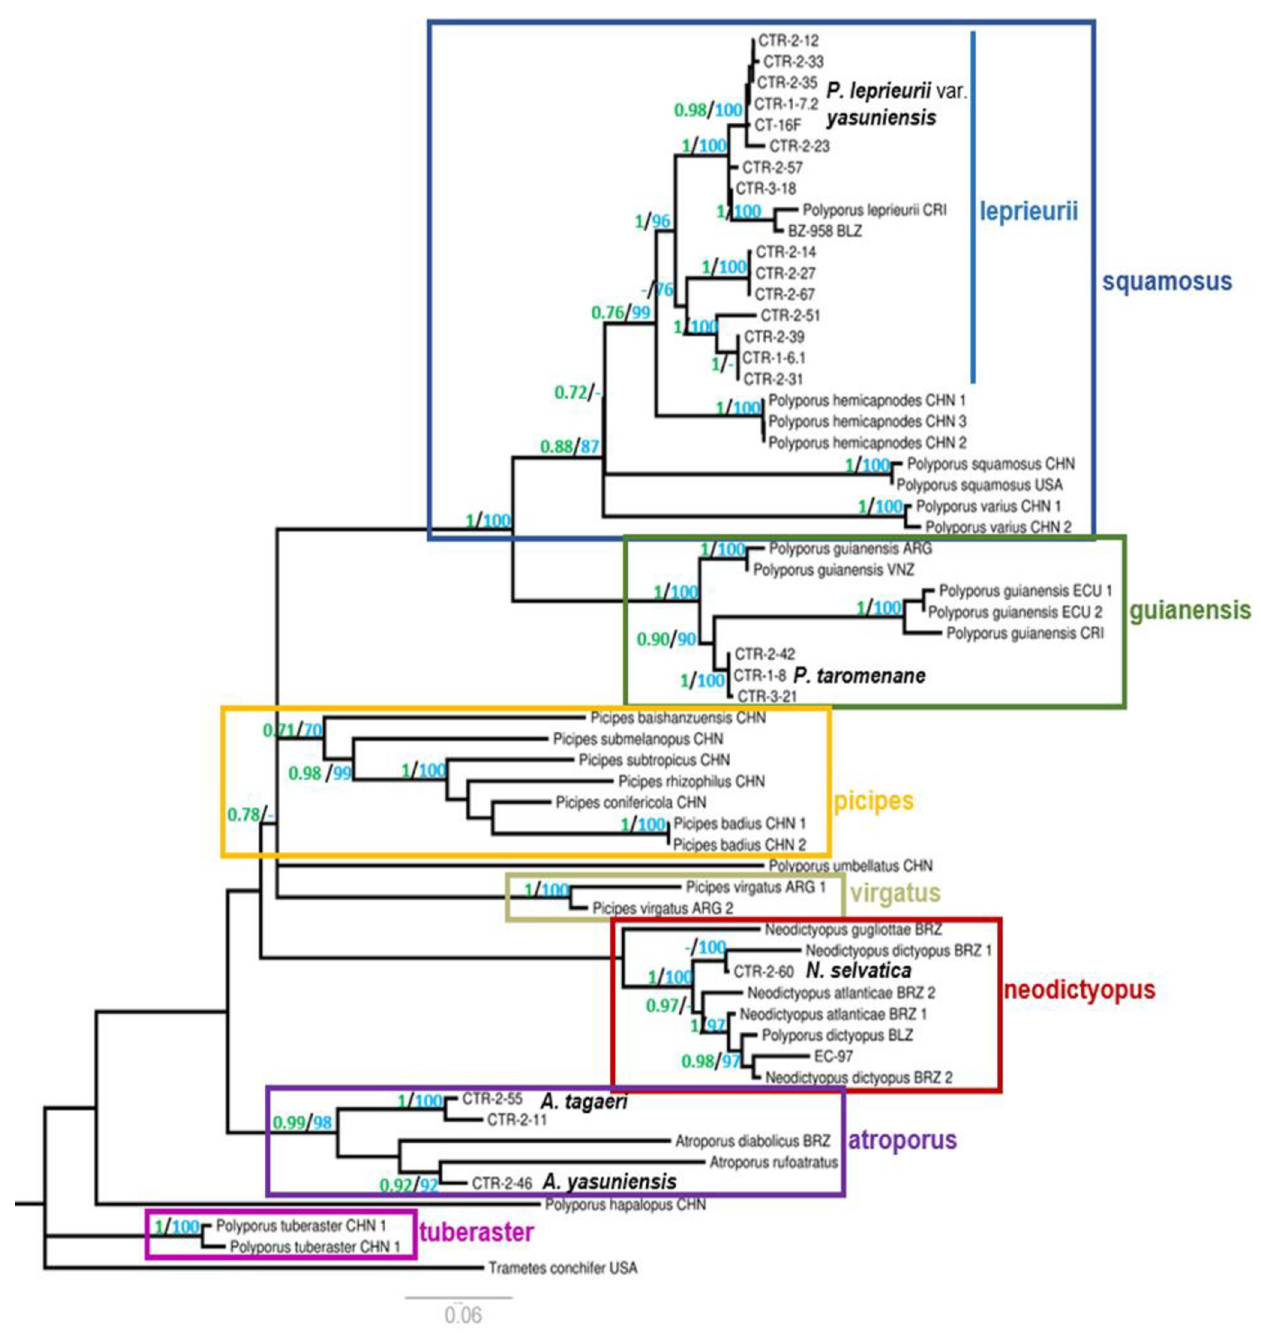
Fig 1. Phylogeny of Polyporus and allied genera inferred from ITS+LSU+EF1- α +RPB1 data. Topology is from Maximum-Likelihood analysis with bootstrap support values of nodes on light blue ( � 70) and posterior probability values ( � 70) of nodes on light green. Bold species are the newly described taxa in this study. ARG = Argentina, BRZ = Brazil, BLZ = Belize, CHN = China, CRI = Costa Rica, ECU = Ecuador, VNZ = Venezuela, and USA = United States.